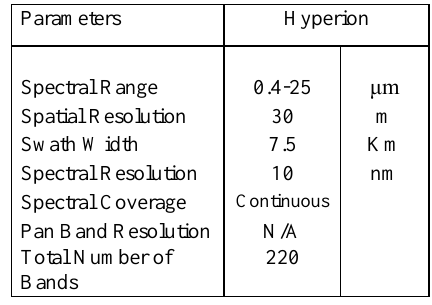
Table 1. Specifications of Hyperion Hyperspectral sensor